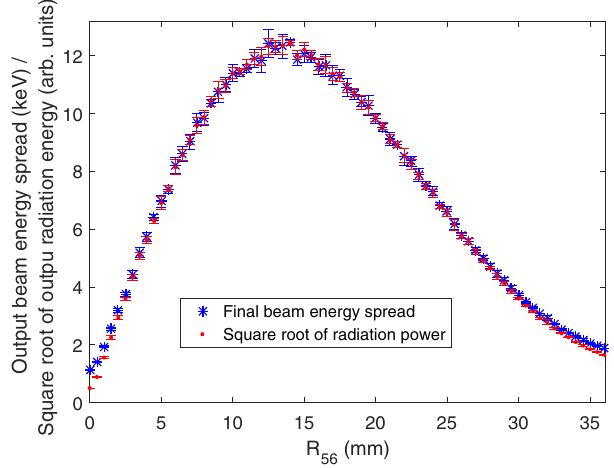
FIG. 6. Output beam energy spread and square root of the output radiation power as a function of the chicane ’ s R 56